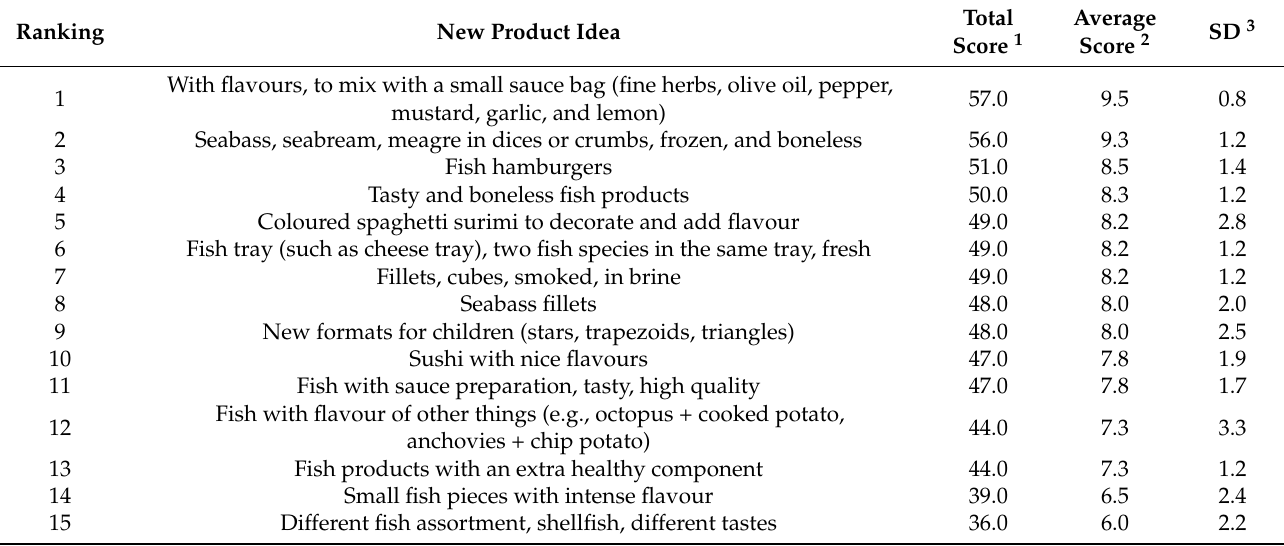
Table A3. Ranking of ideas with higher participant acceptability in